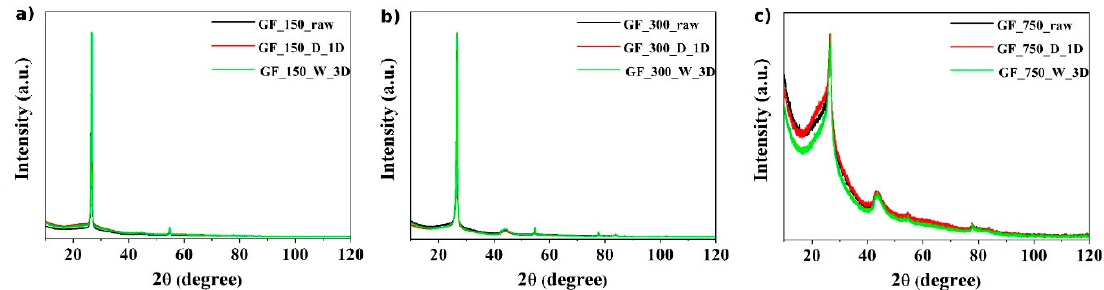
Figure 2. XRD images of three different series of obtained samples: ( a ) GF_150 series, ( b ) GF_300 series and ( c ) GF_750 series.